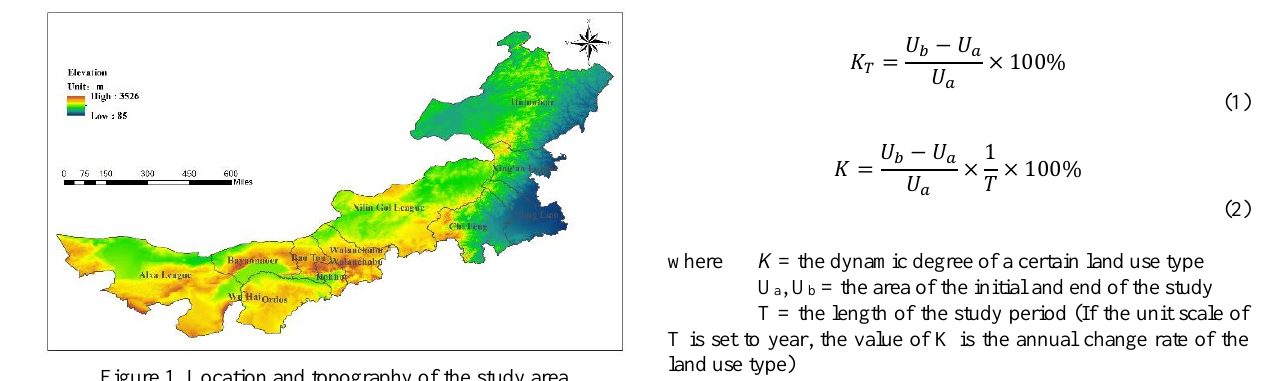
Figure 1. Location and topography of the study